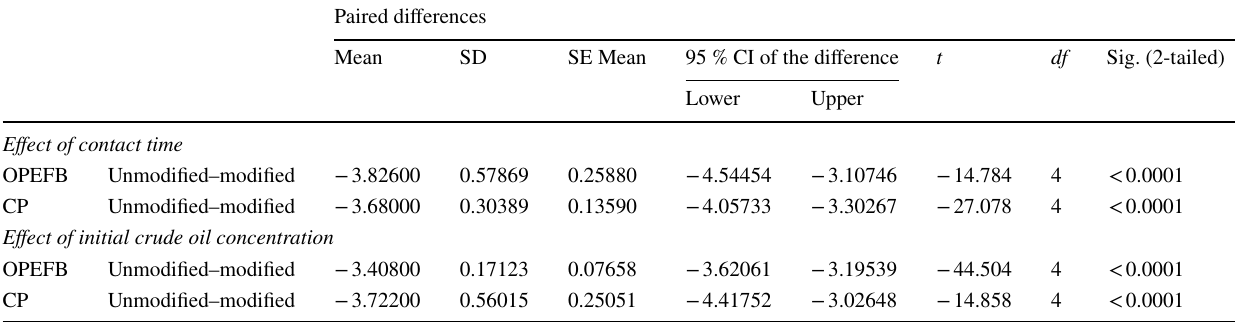
Table 3 Paired samples t test for crude oil sorption capacity of modified and unmodified sorbents Paired